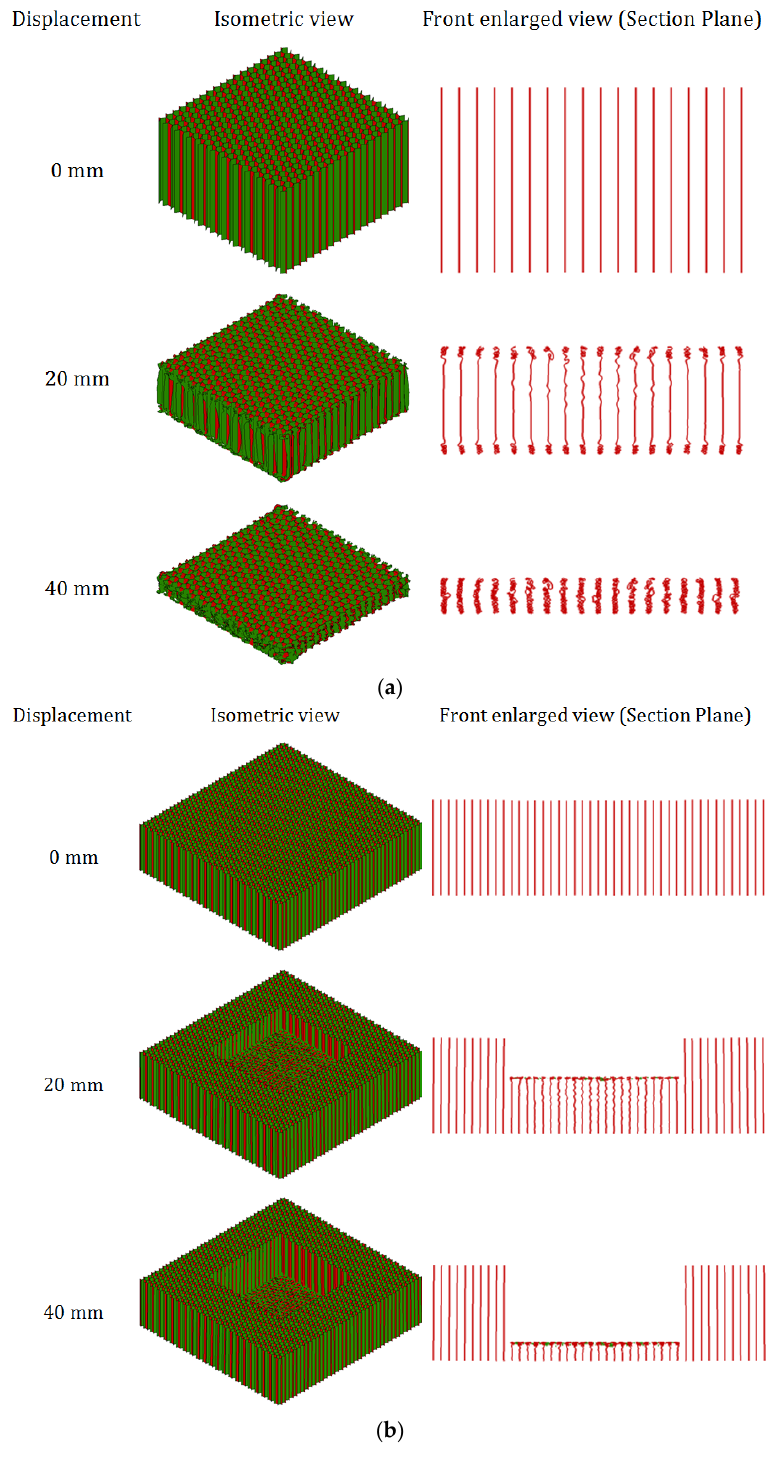
Figure 13. Deformation of honeycomb H31 at 5 ms − 1 : ( a ) compression; ( b ) indentation.